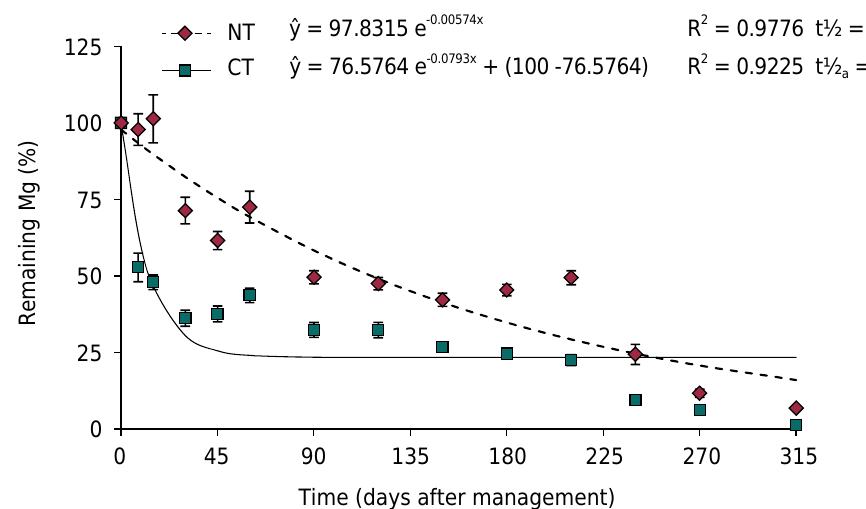
Figure 6. Means of remaining magnesium of aboveground phytomass after management of three mixtures of cover crops in mango interrows in Petrolina, Pernambuco, Brazil (PM1 = 75 % leguminous species + 25 % grass and oilseed species; PM2 = 25 % leguminous species + 75 % grass and oilseed species; and SV = spontaneous vegetation) under two soil tillage systems (NT = no tillage; CT = conventional tillage); t ½ = half-life time, t½ a = half-life time of more easily decomposable compartment. Bars represent the standard error of the